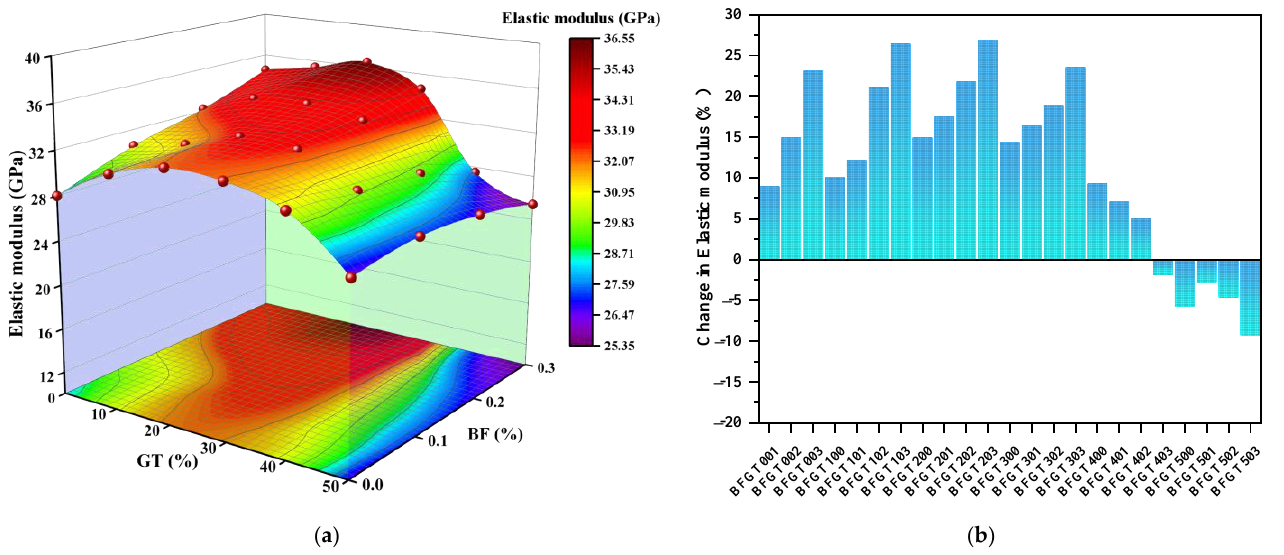
Figure 10. Test results of 28-day age BFR-GTCM elastic modulus: ( a ) elastic modulus at 28 days of age; ( b ) change in elastic modulus at 28 days of age (based on BFGT000).